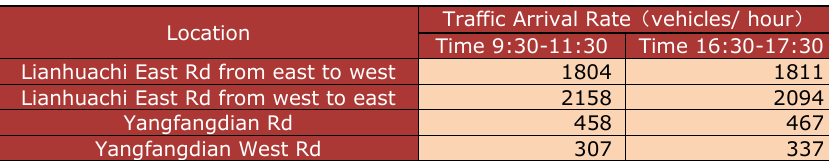
Table 2. Traffic Arrival Rate